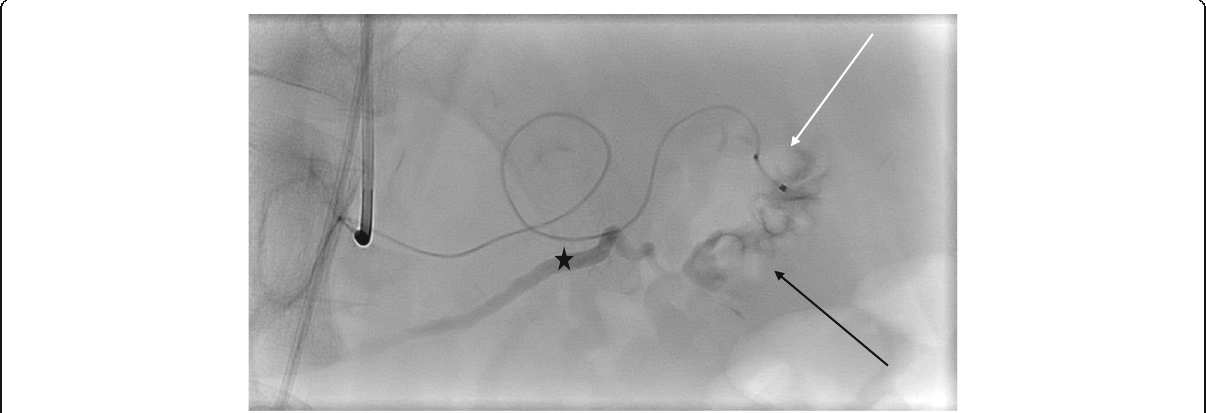
Fig. 2 Microcatheter placed in pseudoaneurysm (white arrow), pancreatico-arterial fistula (black arrow), opacified pancreatic duct (asterisks)